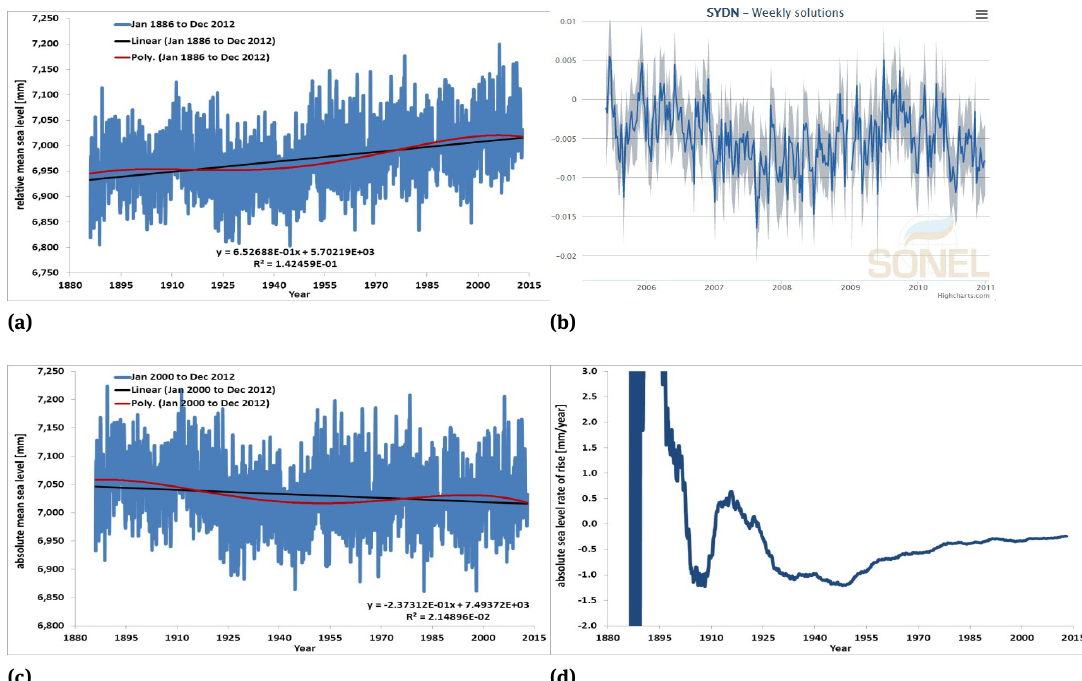
Fig. 6. a: Relative mean sea level measured in Sydney (from PSMSL [16]). The sea level oscillates about a linear trend line of slope 0.65 mm/year with up to quasi-60-year periodicity of oscillations detected; b: land motion in the nearby GPS (from SONEL [15]). There is very likely subsidy in Sydney at a rate of about −0.89 mm/year. c: Absolute mean sea level measured in Sydney. d: absolute sea level rate of rise in